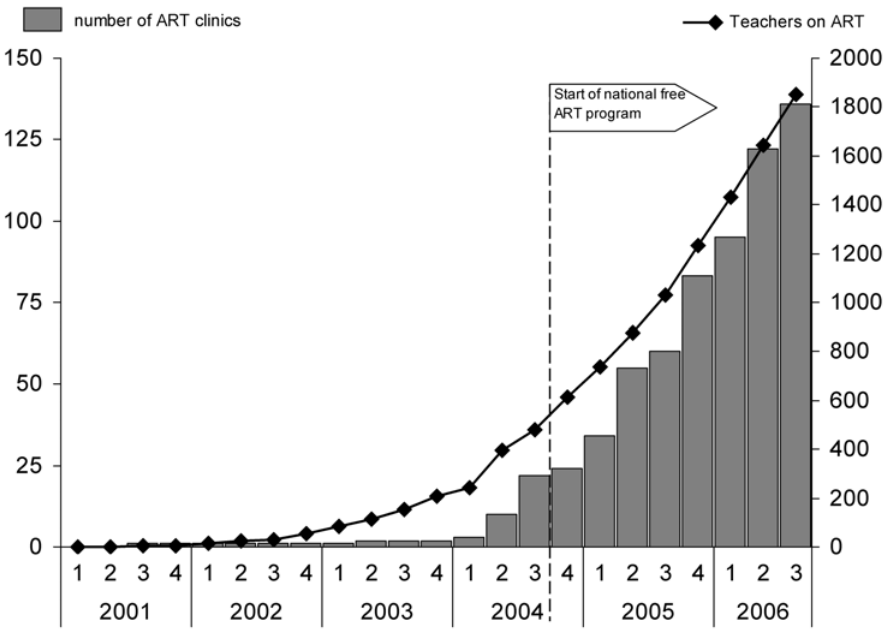
Figure 1. Number of ART clinics in Malawi and number of teachers on ART by the end of the respective quarter.